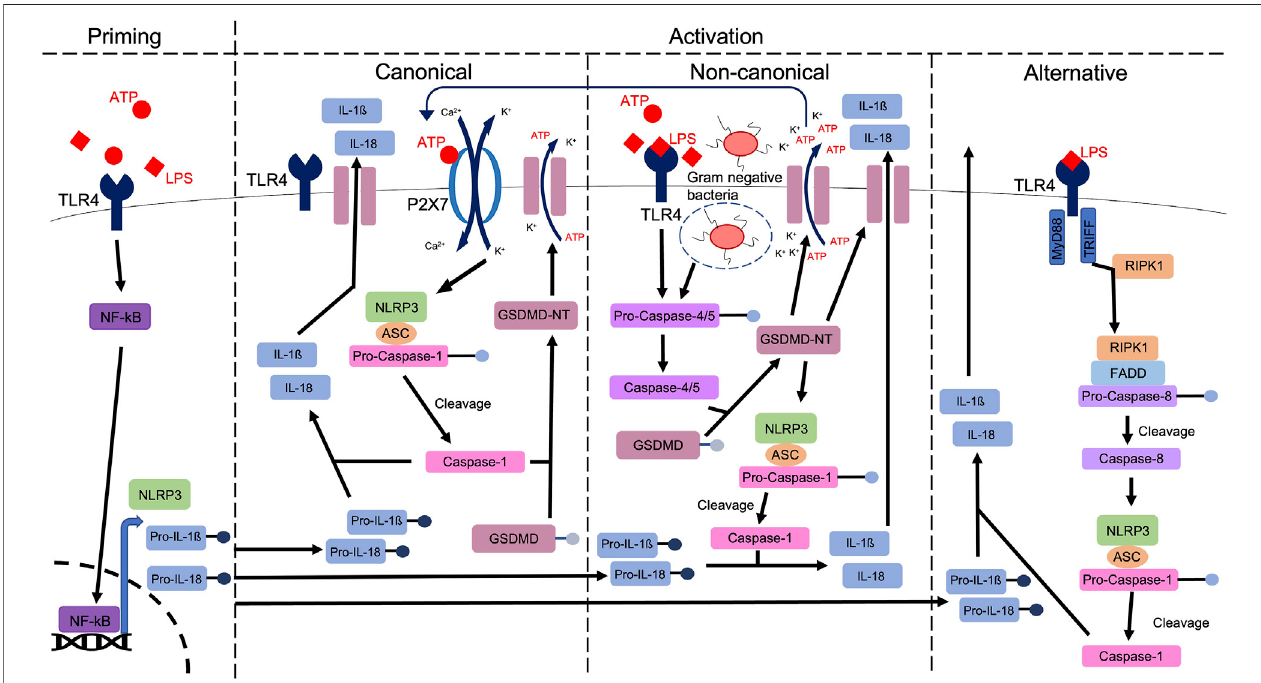
FIGURE1| Aschematichighlightingtheprimingand variousactivationpathwaysoftheNLRP3in fl ammasome.Aprimingsignal(e.g.,ATP),activatesNFkB,which is translocated to the nucleus, to upregulate the expression of NLRP3, pro-IL1ß and pro-IL18. Via either canonical, non-canonical or alternative pathways, caspase-1 mediatedcleavageofpro-IL1ßandpro-IL18producesmatureIL1ßandIL18,aheadofreleasefromthecell,throughmembraneboundchannels,includingGasderminD (GSDMD)pores.Incanonicalsignalling,stimulationofreceptorsincludingTLR4andP2X7Revokespotassiumef fl uxandcalciumin fl ux,stimulatingtheformationof the NLRP3 in fl ammasome. Gasdermin D is cleaved via caspase-1, leading to pore formation (Coll et al., 2022). In non-canonical signalling, activation of caspase-4/5 stimulates GSDMD cleavage. The resulting amino-terminal fragment (GSDMD-NT) initiates pyroptosis and NLRP3 activation, stimulating release of DAMPs including ATP which can then activate the canonical pathway via P2X7R. In the alternative pathway, Toll or interleukin-1 receptor (TIR) domain-containing adaptor inducing interferon- β (TRIFF) and TLR4-receptor-interacting protein kinase 1 (RIPK1) interaction leads to the formation of a RIPK1-Fas-associated with death domain protein (FADD)-pro-caspase-8 complex. Pro-caspase-8 is cleaved, allowing mature caspase-8 to activate the NLRP3 in fl ammasome, ahead of IL1ß and IL18